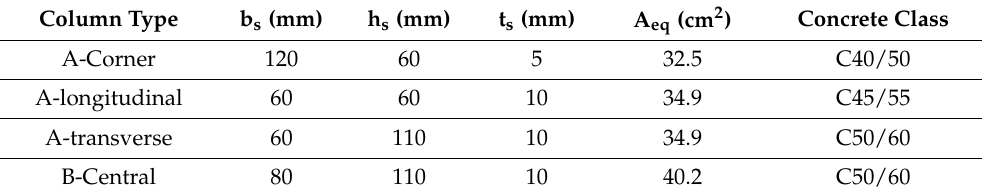
Table 7. Local intervention technique with steel angles and batten plates—second hypothesis. Column Type b s (mm) h s (mm) Concrete Class